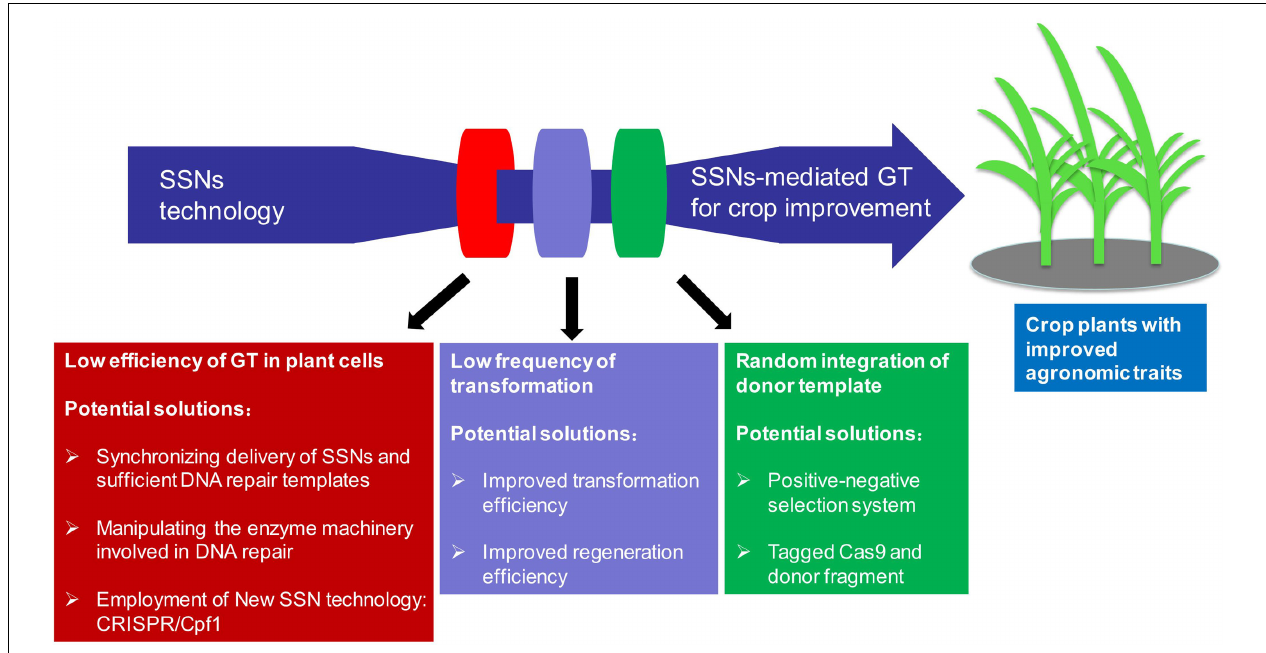
FIGURE 3 | Current challenges and future perspectives in applying SSNs-mediated gene targeting (GT) for crop